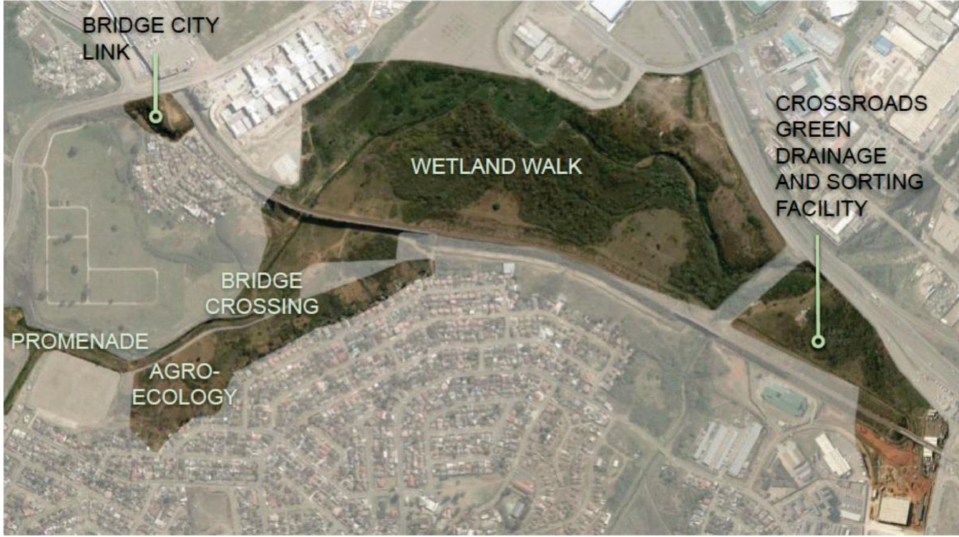
Figure 5. The Piesang’s River flood plain area, indicating the six sites for the students’ design projects. Source: Author,